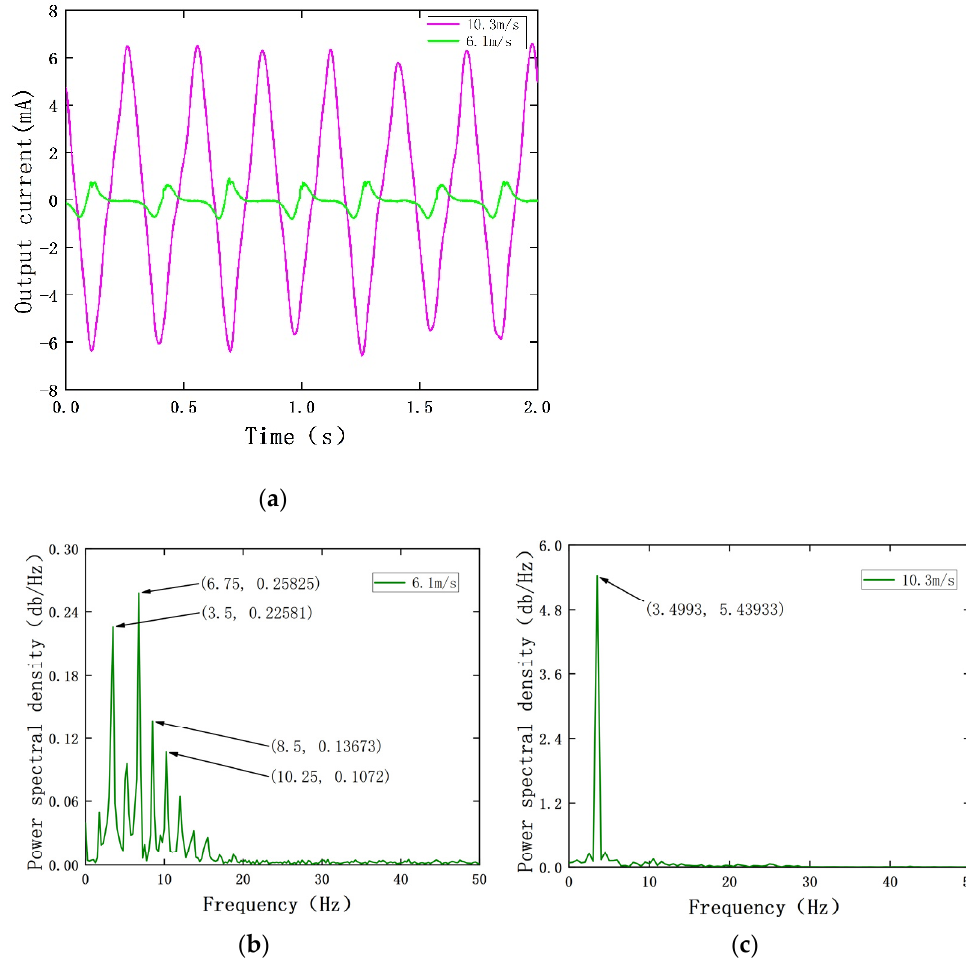
Figure 5. The output performance of the EEH at different wind speeds: ( a ) output voltage of the EEH; ( b ) output power spectrum density of the EEH at 6.1 m/s; ( c ) output power spectrum density of the EEH at 10.3 m/s.